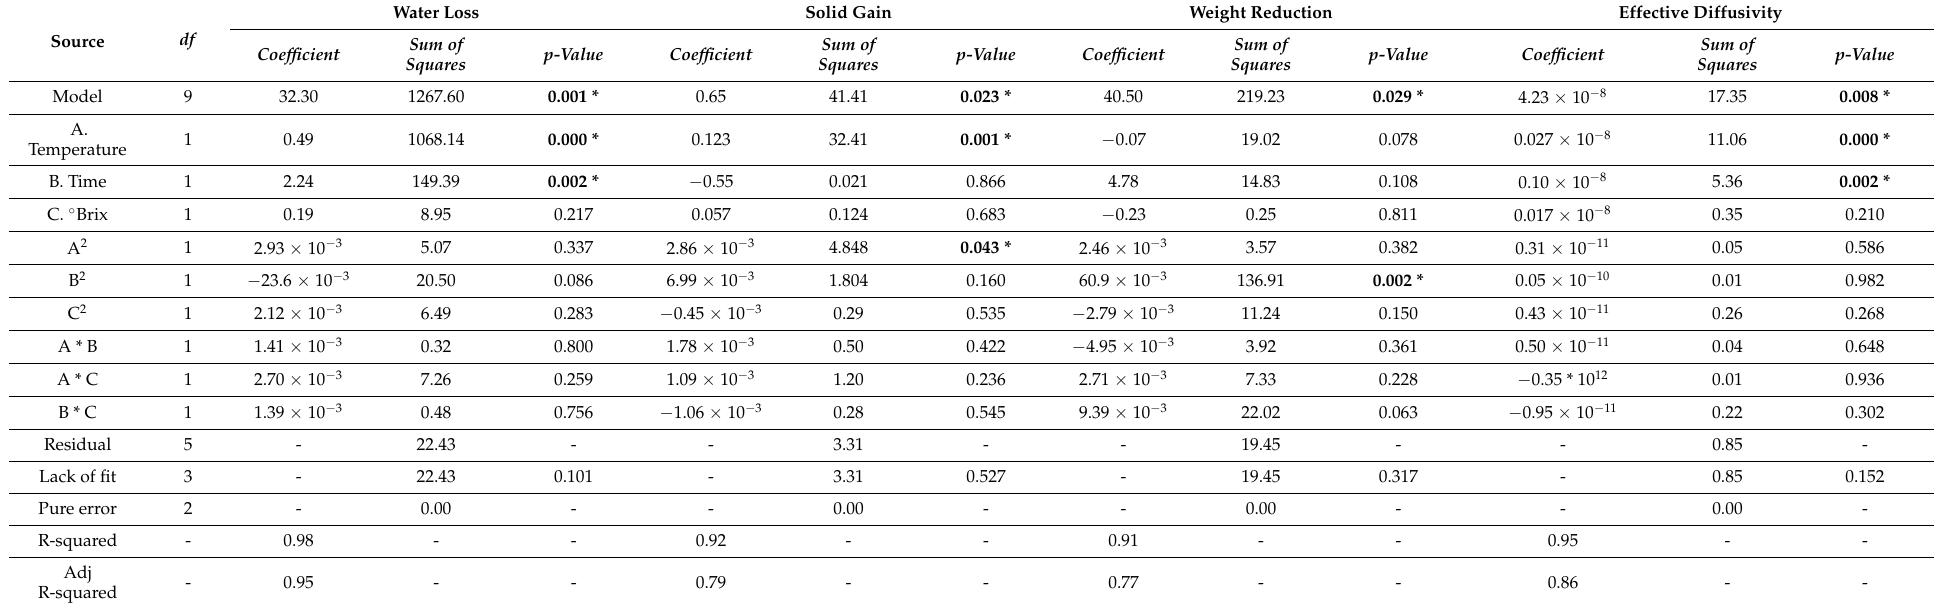
Table 5. Analysis of variance and regression analysis for OD in the sucrose osmotic solution: weight reduction, solid gain, water loss, and effective